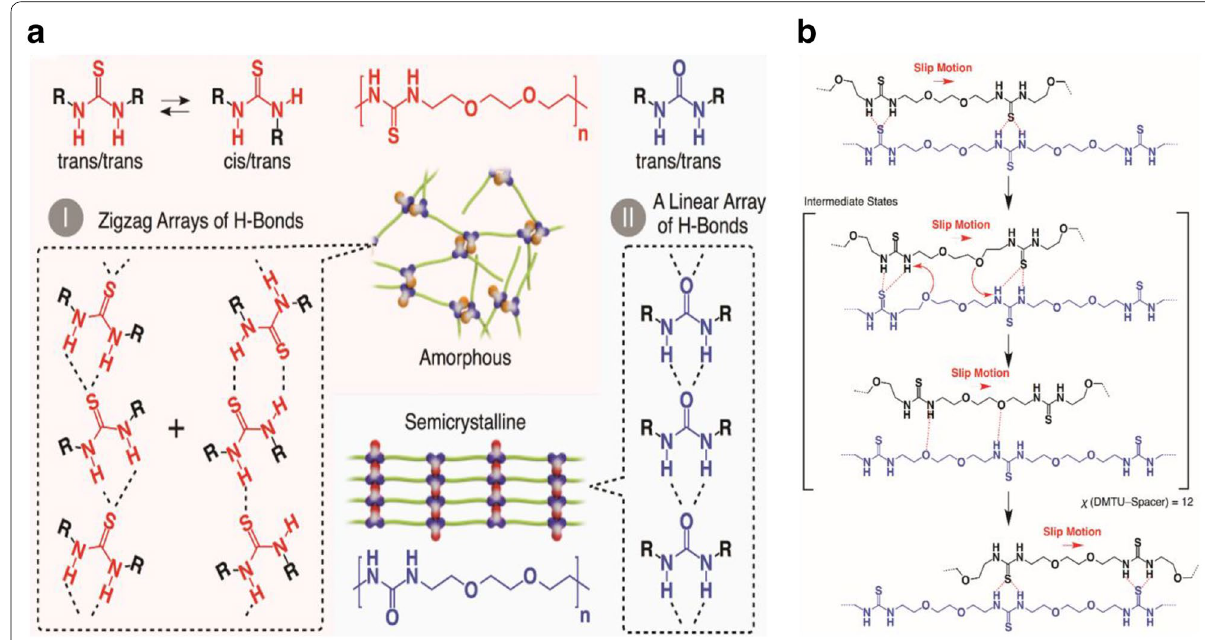
Fig. 6 H-bonding approach of thiourea and urea moieties: a thiourea units which form nonlinear zigzag arrays adopting cis/trans and strained trans/trans conformations (I), whereas urea groups form linear arrays of H-bonding adopting only a trans/trans conformation (II); b proposed mechanism for transformations of H-bonded thiourea pairs. The triethylene glycol spacer that connects the thiourea units optimally modulates the exchange of H-bonded thiourea pairs; consequently, the highly crosslinked non-covalently, can heal by only compression without heating (reproduced with permission from: Ref. [58], ©2018